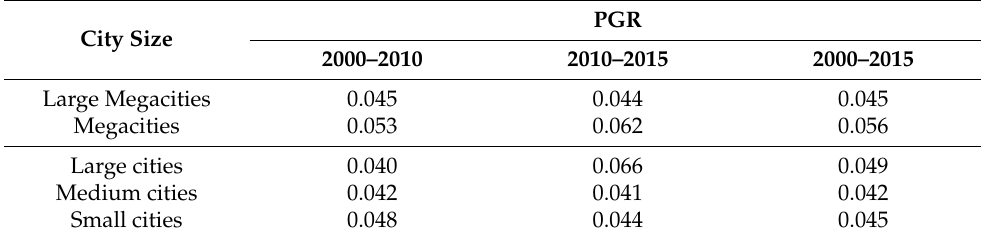
Table 3. The classification results of population growth rate.